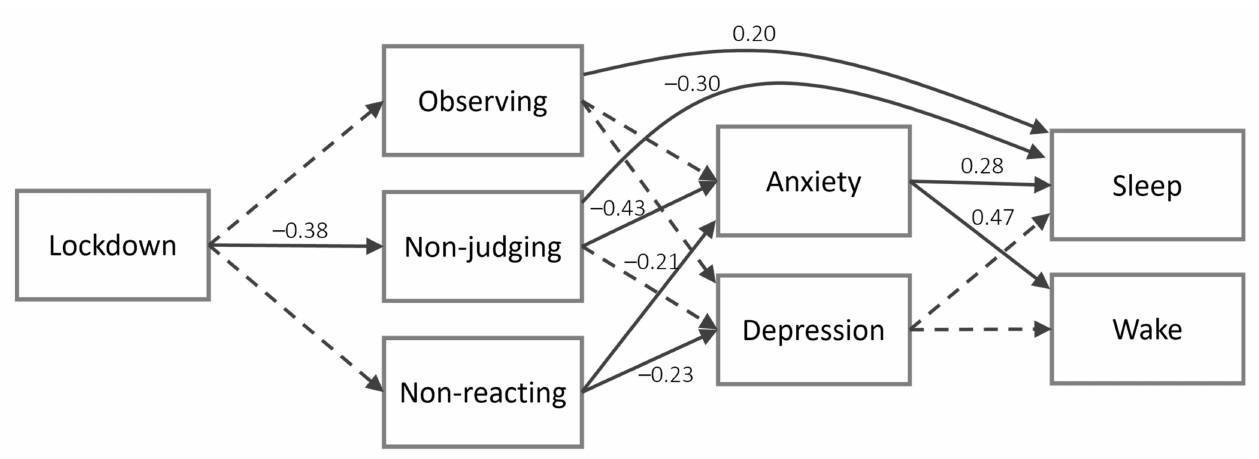
Figure 2. Second model including all the subscale scores. Continuous arrows represent significant paths, while dotted arrows represent non-significant paths. Standardized coefficients are reported only for significant paths. For the sake of clarity, only the direct paths from lower levels to higher levels that were significant are shown: e.g., the paths from lockdown to distress and sleep variables are not shown because they were not